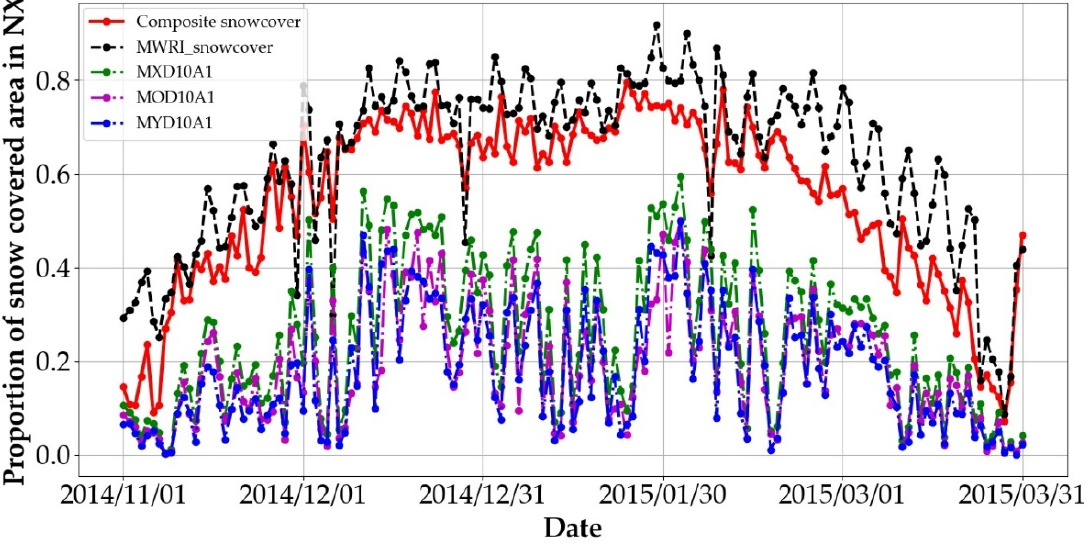
Figure 8. Variation of snow cover in each dataset.